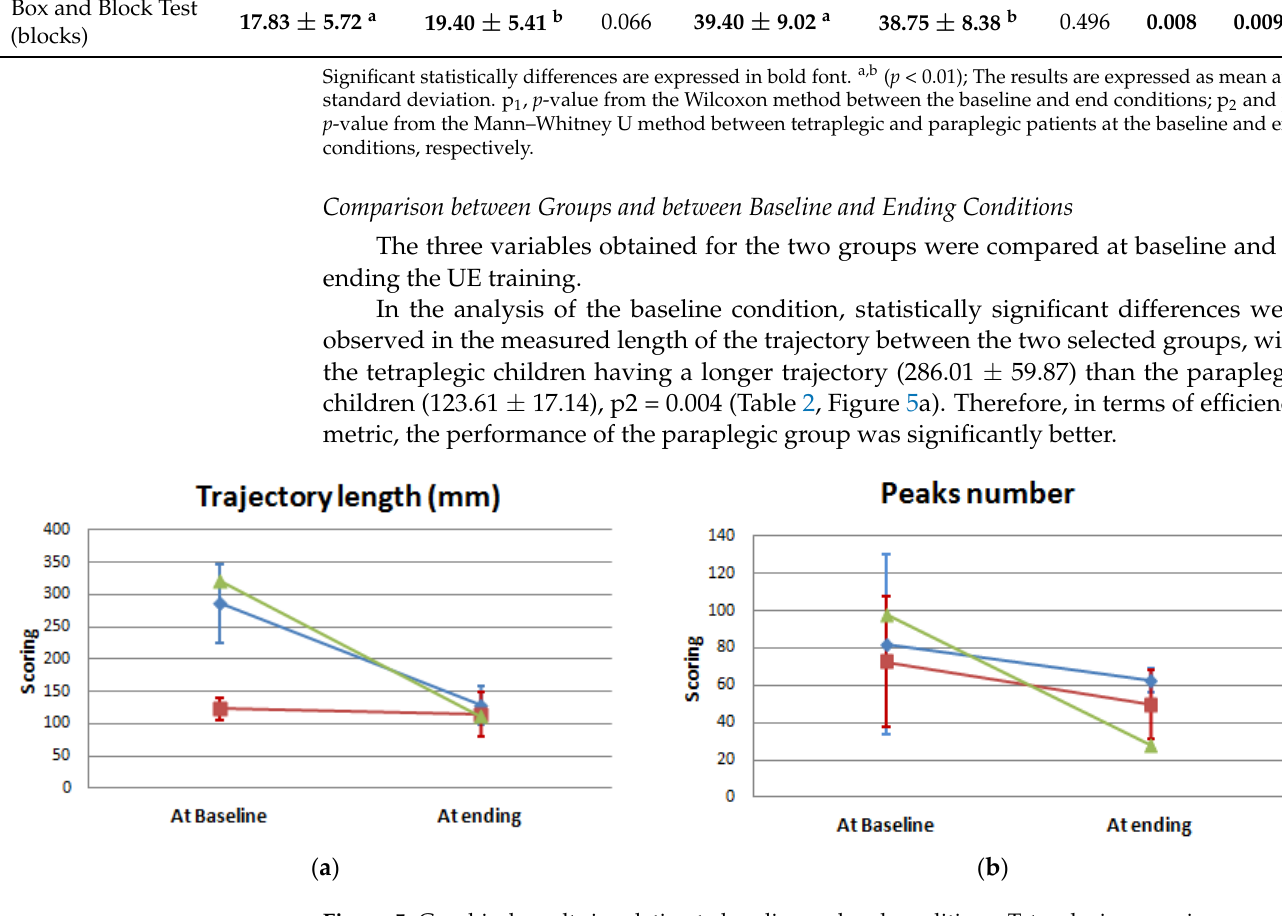
Figure 5. Graphical results in relation to baseline and end conditions. Tetraplegic group is expressed as blue color, paraplegic as red color and the case of a single patient as green color: ( a ) Results about trajectory length; ( b ) Results about the peaks